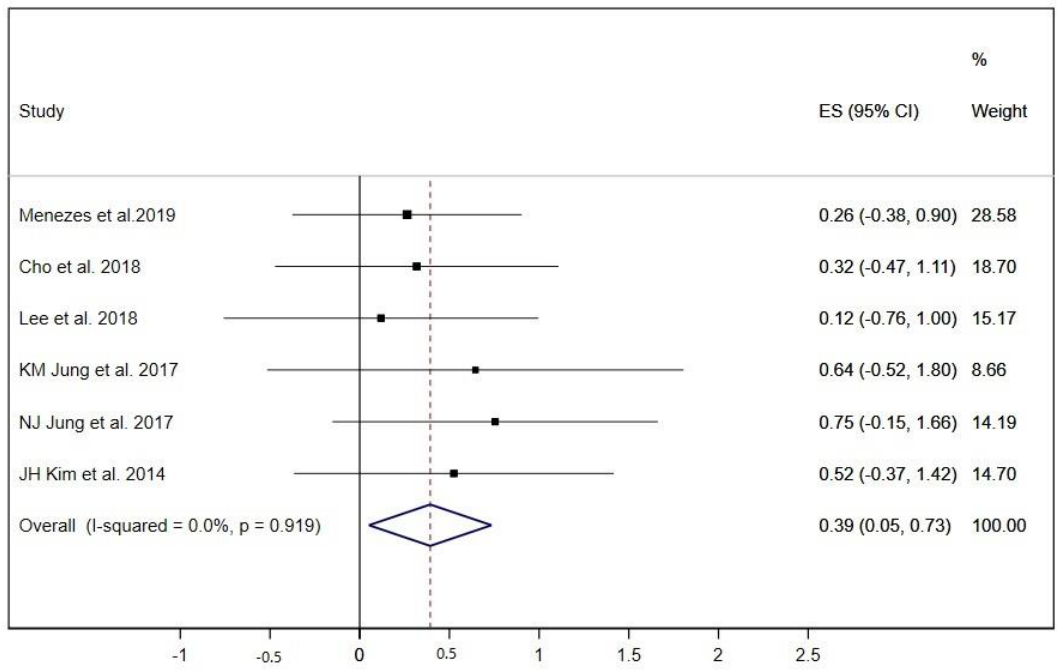
Figure 7. Forest plot showing the effect size (ES) of respiratory muscle training (RMT) on 6 min walking test (6-MWT) between intervention and control groups for each study. IMT, inspiratory muscle training; EMT, expiratory muscle training.